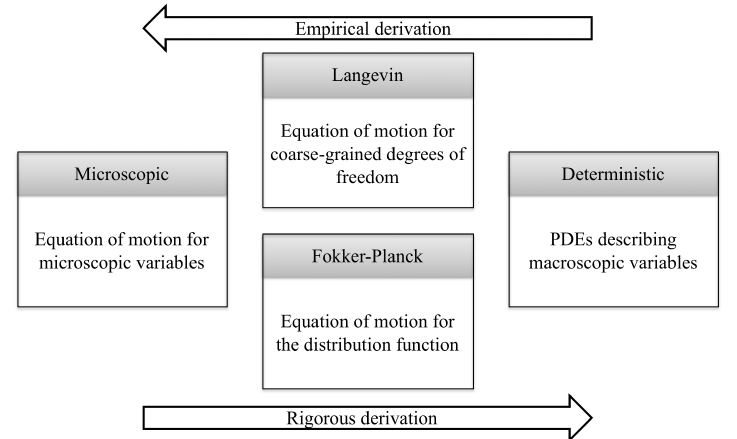
Figure 4. Levels of description of a system, adapted from